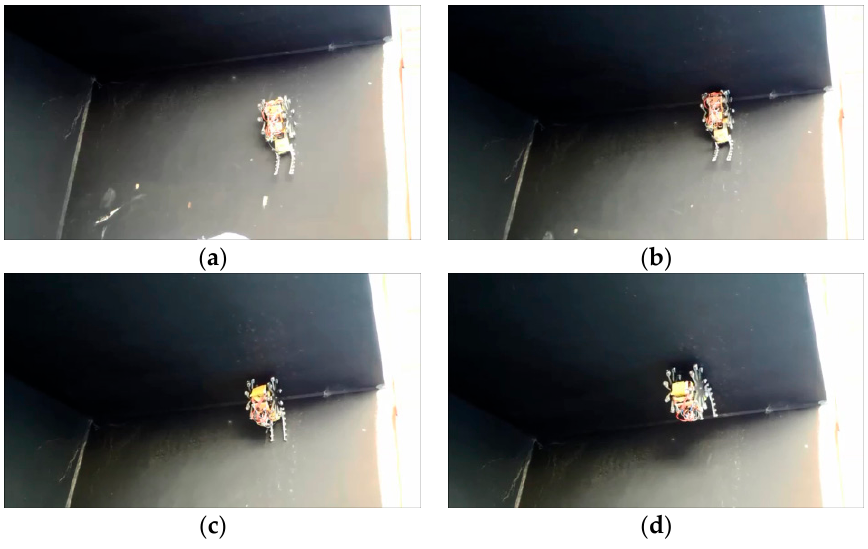
Figure 12. BIREM 3rd moving along route 2. ( a ) 0 s; ( b ) 3.3 s; ( c ) 6.7 s; ( d ) 10 s.